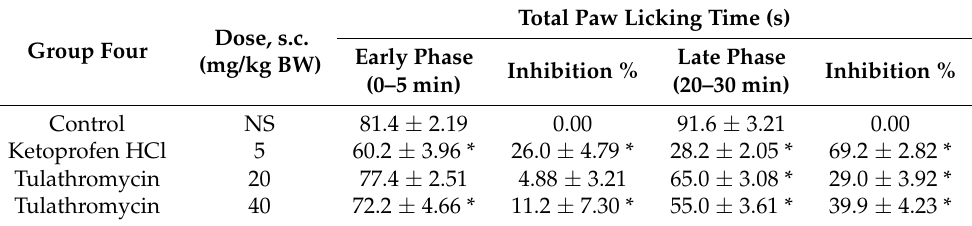
Table 4. Effects of tulathromycin (20 and 40 mg/kg, SC) and ketoprofen (5 mg/kg BW s.c.) on the nociceptive responses triggered by s.c. injection of formalin (20 ul of 2.5%, v / v ) in the dorsum of the hind right paw in mice (mean ± SD; n =